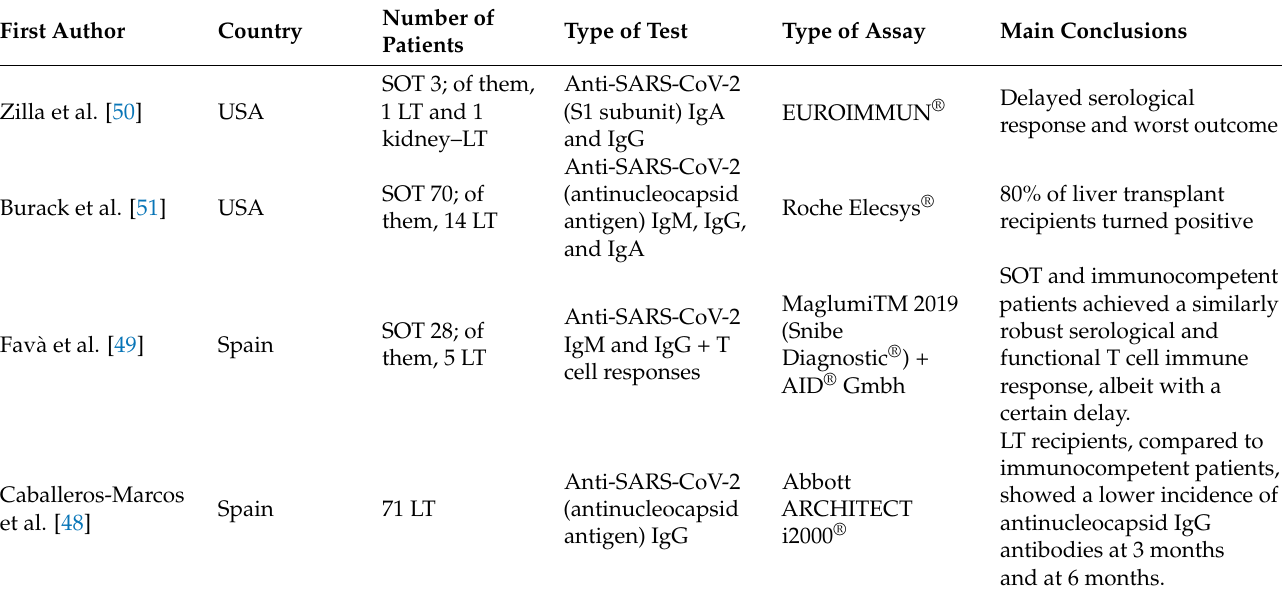
Table 3. Summary of the included studies concerning immunological response of LT recipients after